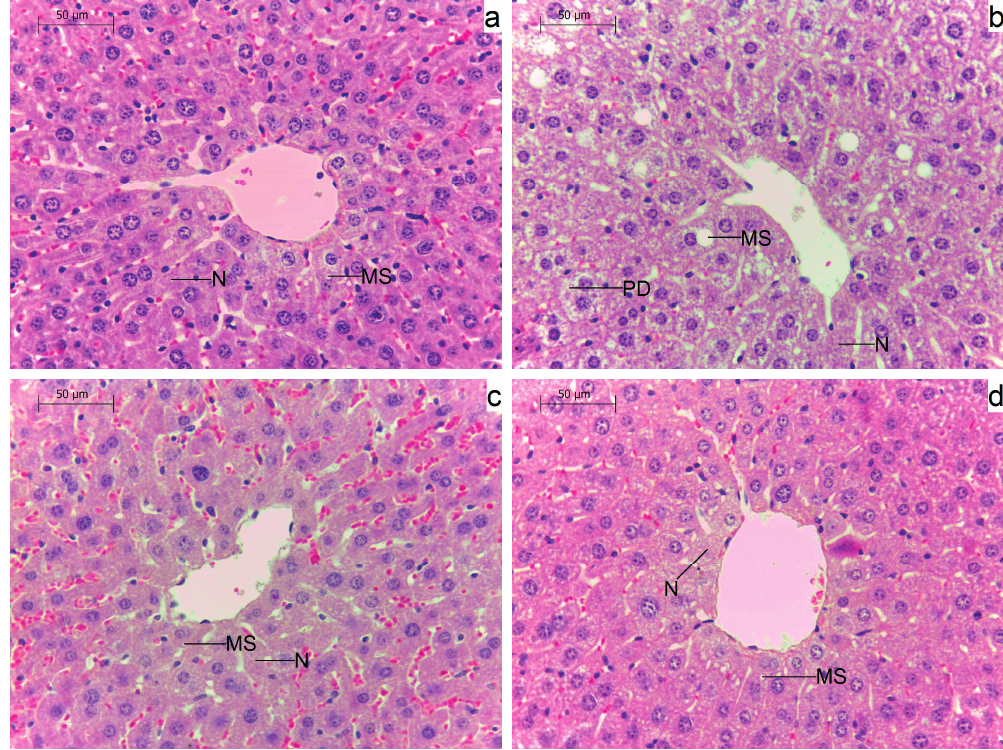
Figure 5. Histopathological examination of mice liver by hematoxylin and eosin staining. Animals administered different diets: ( a ) SD (standard diet); ( b ) HFD (high-fat diet); ( c ) Linola; and ( d ) GT#4. Parenchymatous degeneration (PD), microvesicular steatosis (MS), necrosis (N). 20×